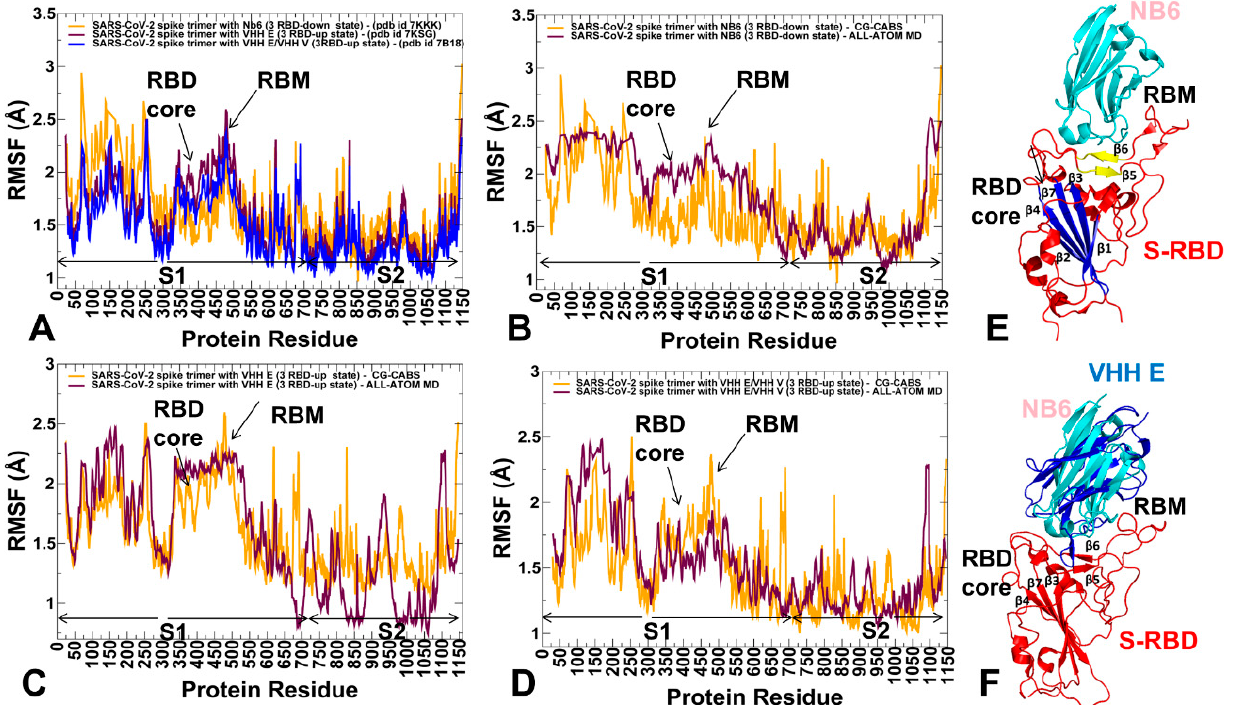
Figure 2. Conformational dynamics profiles of the SARS-CoV-2 S trimer complexes with nanobodies. ( A ) The root mean square fluctuations (RMSF) profiles obtained from CG-CABS simulations of the SARS-CoV-2 S trimer in the complex with Nb6 nanobody, pdb id 7KKK (in orange lines), S trimer in the complex with VHH E nanobody, pdb id 7KSG (in maroon lines), and S trimer in the complex with VHH E/VHH V nanobody, pdb id 7B18 (in blue lines). ( B ) The RMSF profiles of the SARS-CoV-2 S trimer in the complex with Nb6 obtained from CG-CABS simulations (in orange lines) and all-atom MD simulations (in maroon lines). ( C ) The R MSF profiles of the SARS-CoV-2 S trimer in the complex with VHH E obtained from CG-CABS simulations (in orange lines) and all-atom MD simulations (in maroon lines). ( D ) The RMSF profiles of the SARS-CoV-2 S trimer in the complex with VHH E/VHH V obtained from CG-CABS simulations (in orange lines) and all-atom MD simulations (in maroon lines). The position of the S-RBD core and flexible RBM regions are indicated by arrows. The S1 subunit (residues 14–685) and S2 subunit (residues 686–1163) are highlighted. The S1 domains include NTD (residues 14–306), RBD (residues 331–528), CTD1 (residues 528–591), CTD2 (residues 592–685). The S2 domains and functional regions of the simulated structures include upstream helix (UH) (residues 736–781), fusion peptide proximal region (FPPR) segment (residues 828–853), heptad repeat 1 (HR1) (residues 910–985), central helix region (CH) (residues 986–1035), connector domain (CD) (residues 1035–1068), heptad repeat 2 (HR2), (residues 1069–1163). ( E ) Structural organization of the S-RBD (shown in red ribbons). The central β strands ( β 1 to β 4 and β 7) (residues 354–358, 376–380, 394–403, 431–438, 507–516) are shown in blue. β 5 and β 6 strands (residues 451–454 and 492–495) are shown in yellow. The bound nanobody Nb6 is shown in cyan ribbons. ( F ) Superposition of Nb6 nanobody (in cyan ribbons) and VHH E nanobody (in blue ribbons). S-RBD is in red ribbons.